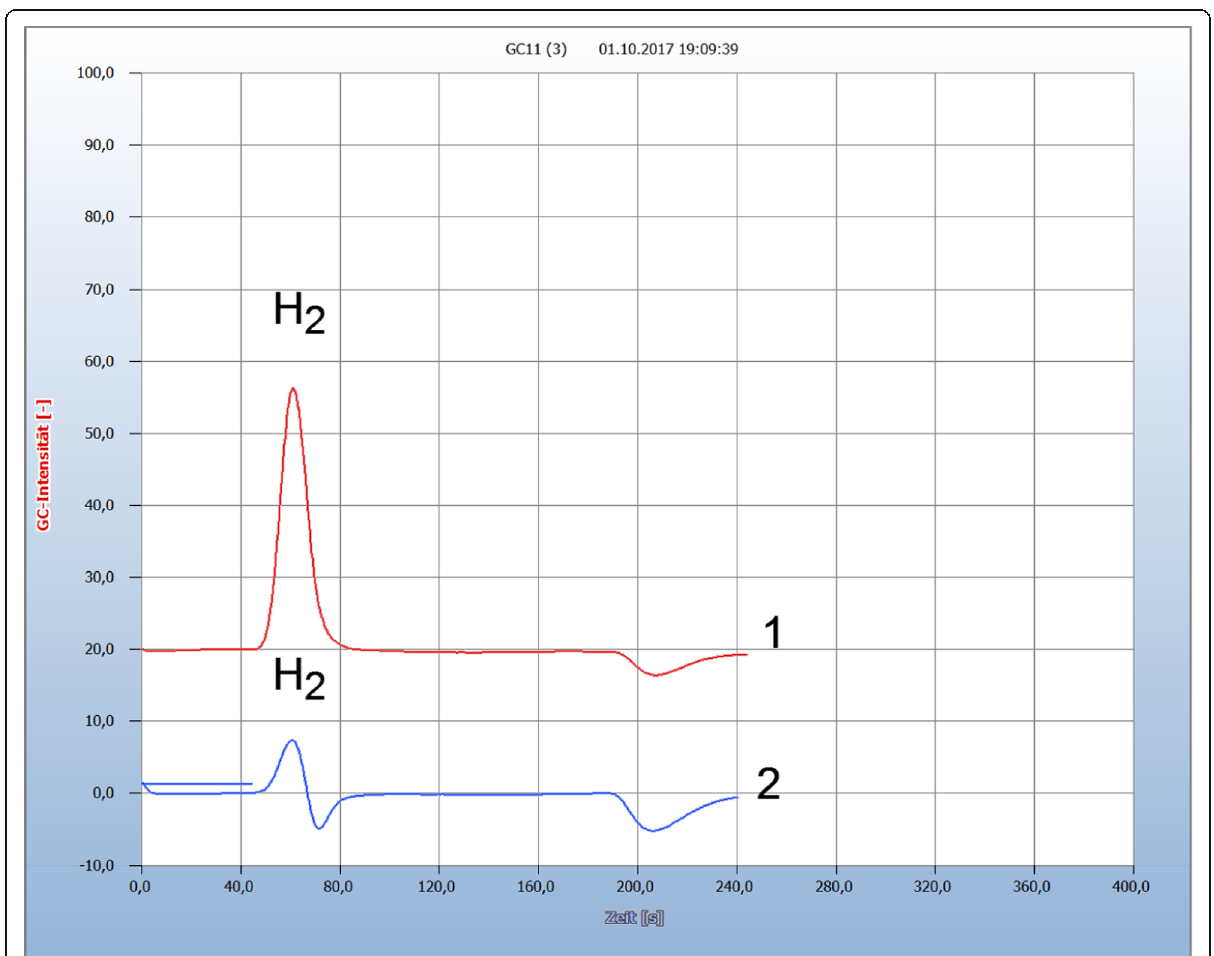
Fig. 5 Antibiotic resistance in the leg of a chicken. 1, leg of chicken; 2, added penicillin. GC-column 1: silica